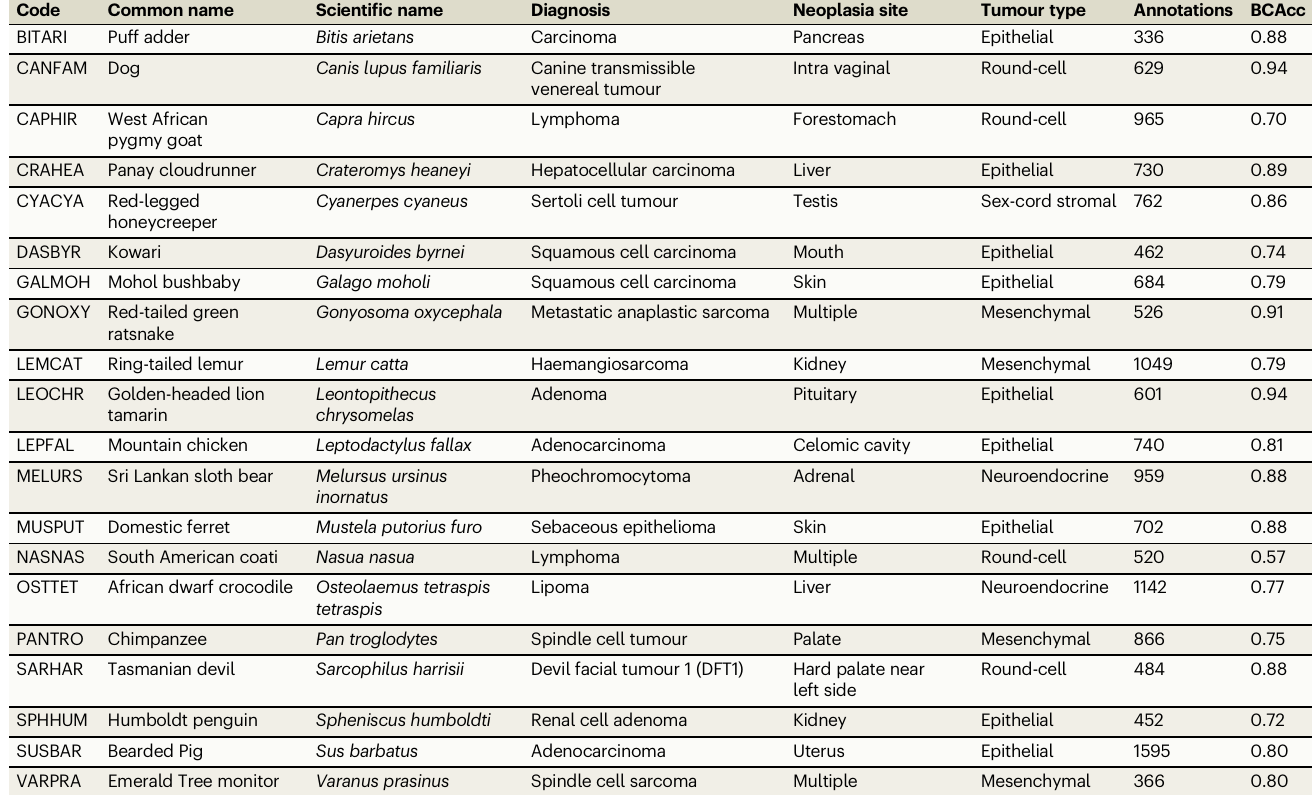
Table 1 | Summary of overall balanced classi fi cation accuracy (BCAcc) by species. Balanced accuracy is computed as the average of sensitivity and speci fi city for cancer, stromal and lymphocyte